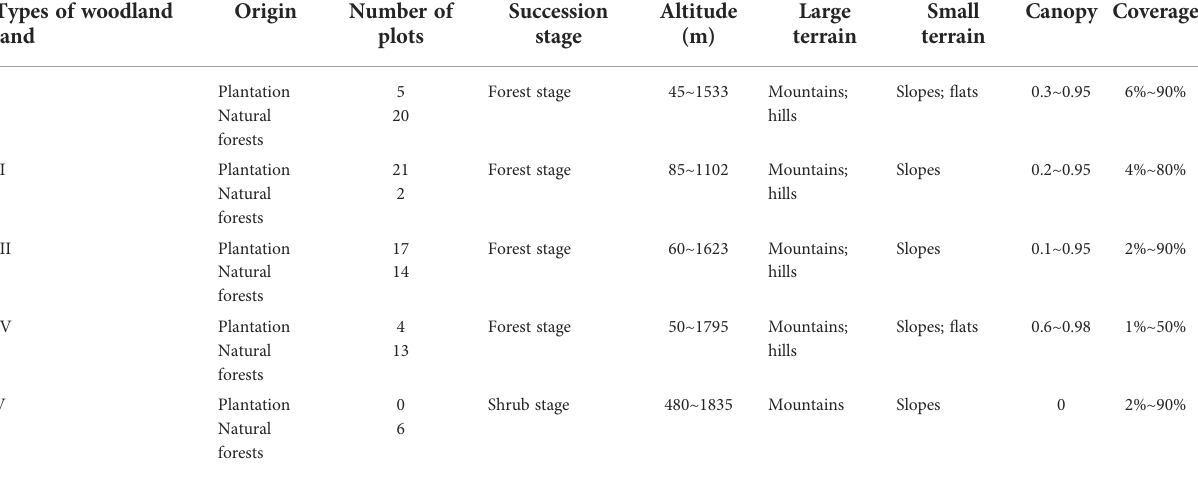
TABLE 2 Basic information of plots of different forest land